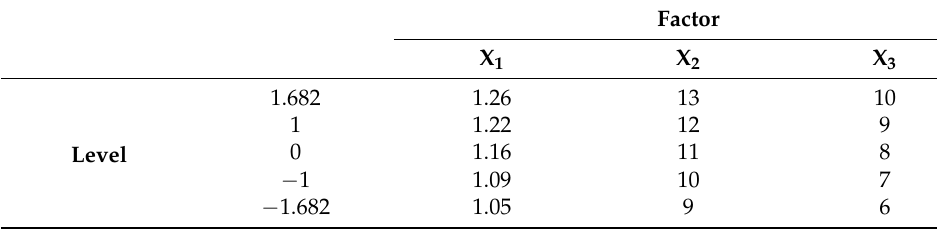
Table 2. Factor and level of test.